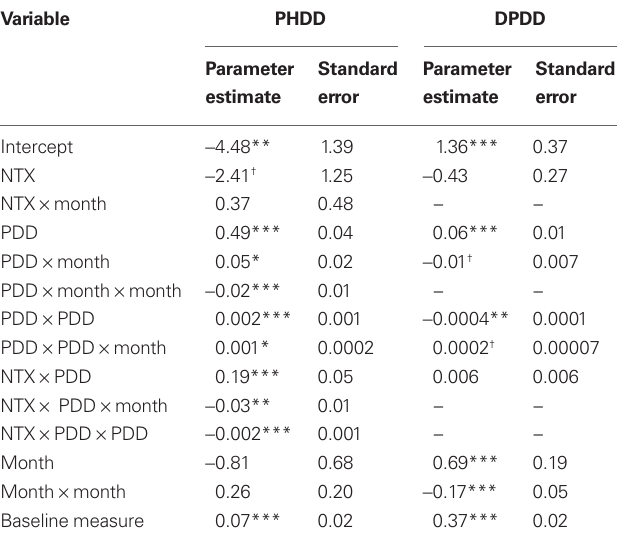
Table 1 | Parameter estimates and standard errors from trimmed multilevel growth models of percent heavy drinking days (PHDD) and drinks per drinking day (DPDD) outcome